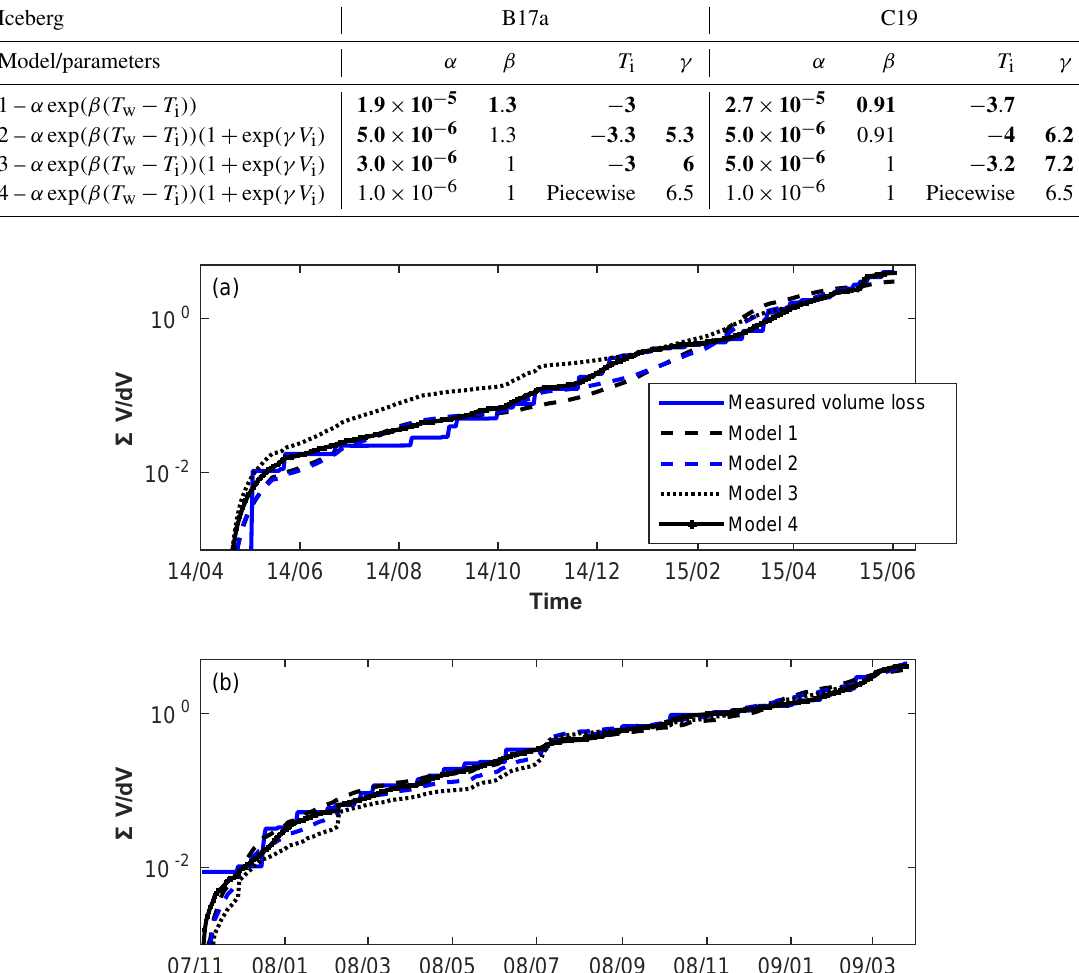
Table 1. Fragmentation models and parameters. The bold characters represent fitted parameters while the regular characters represent the fixed values. Iceberg B17a C19 Model/parameters